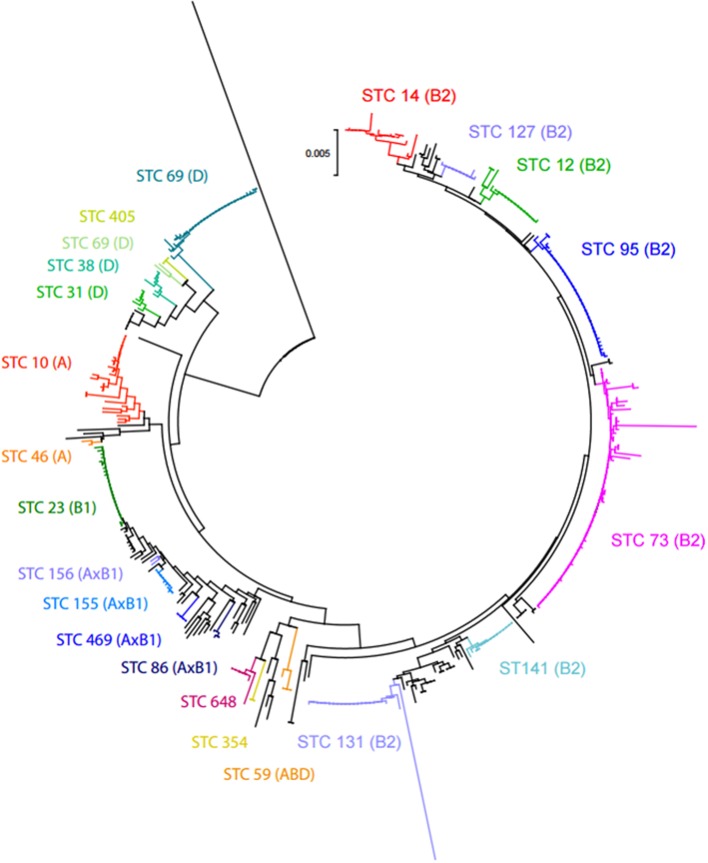
Neighbor-joining tree obtained from the concatenated sequences of the 7 MLST loci of
E. coli
isolates from BSI in 2014. The 12 major ST complexes (and their respective phylogroups) are placed on the tree.